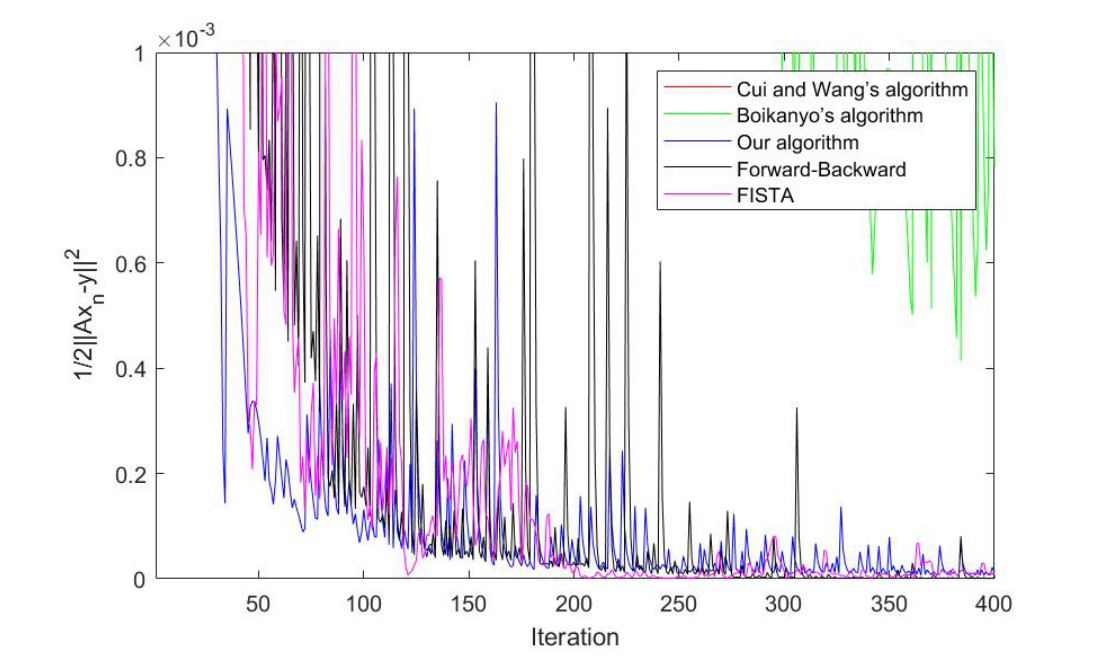
Figure 3. Case N = t = 10 and k = 10.